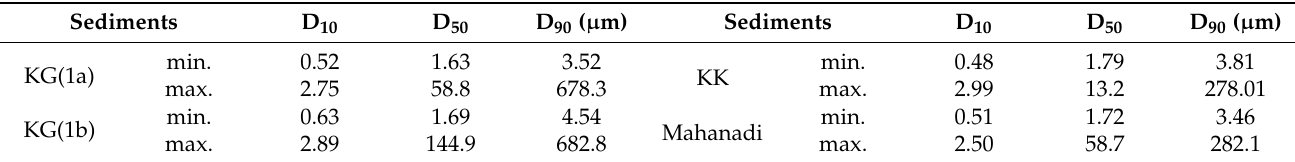
Table 3. Minimum and maximum value of particle size